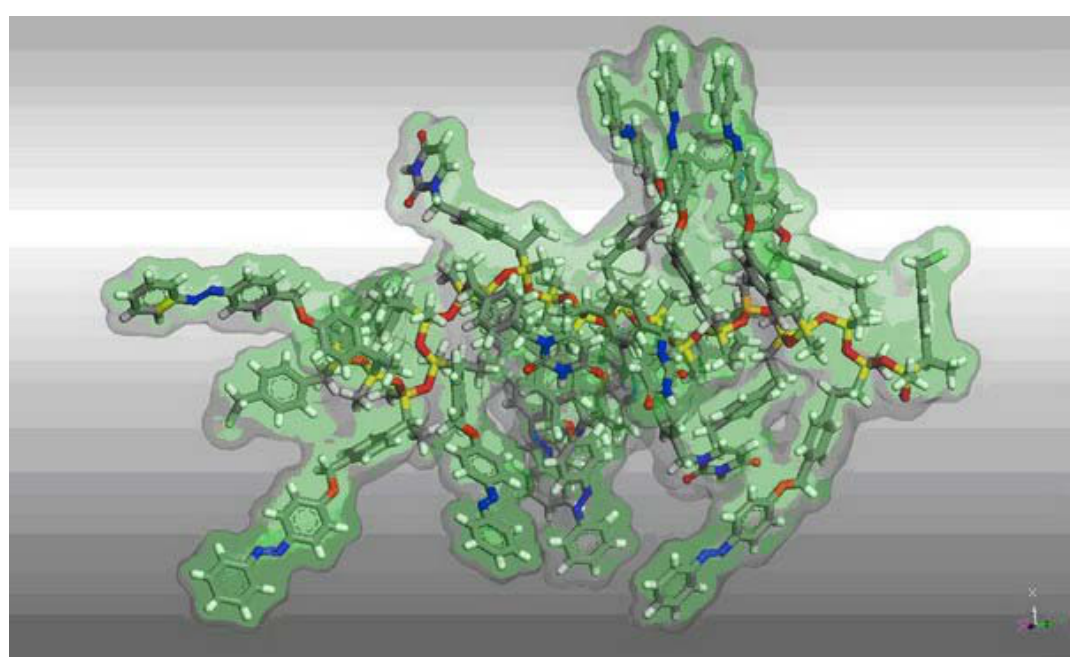
Fig. 5 Minimum energy geometry corresponding to an azo-polysiloxane modified with uracil groups.